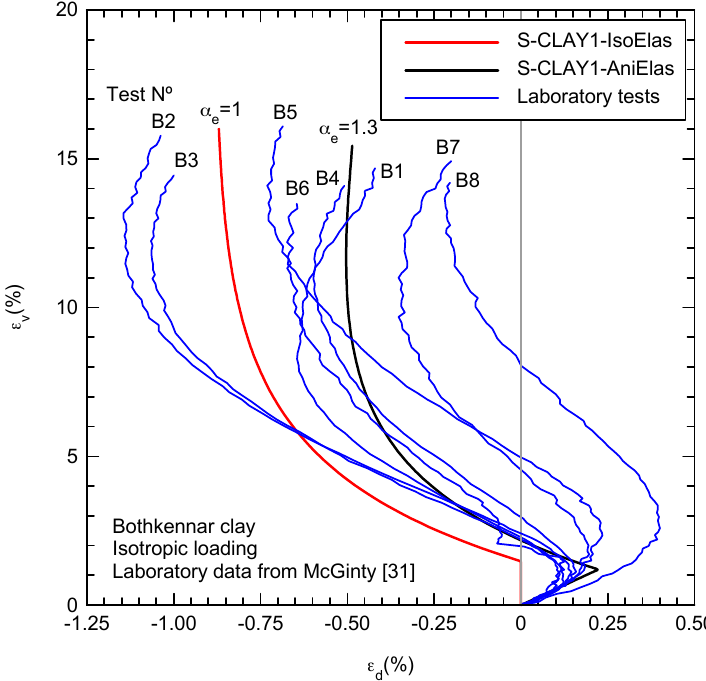
Figure 2. Influence of elastic anisotropy during isotropic compression (thin blue lines are laboratory results [31] and thicker red and black lines are S-CLAY1 predictions using isotropic and anisotropic elasticity, respectively).